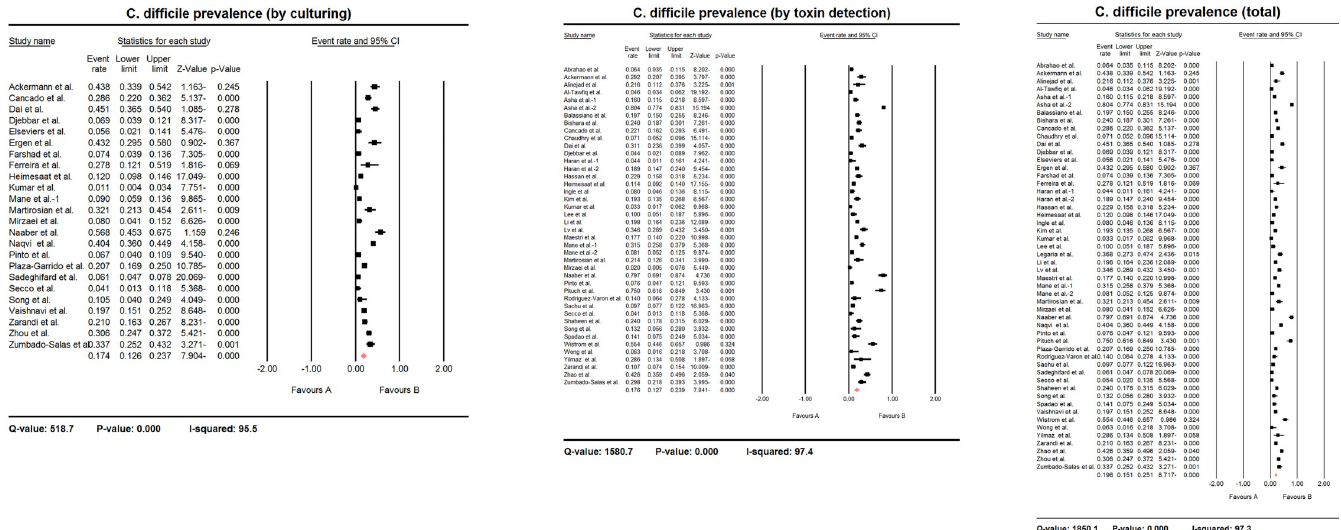
Fig 2. The forest plots of prevalence of C . difficile in AAD patients. The plots indicate the estimated pooled prevalence of C . difficile in AAD patient based on culturing, toxin detection or regardless the detection method (total). The heterogeneity test results are shown below each plot.